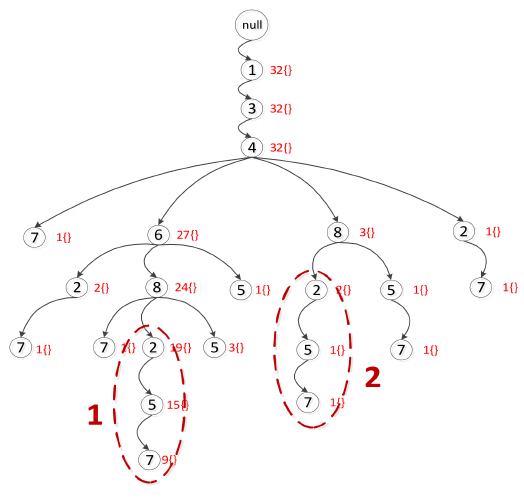
Figure 8. Combining the repeated frequent itemsets.